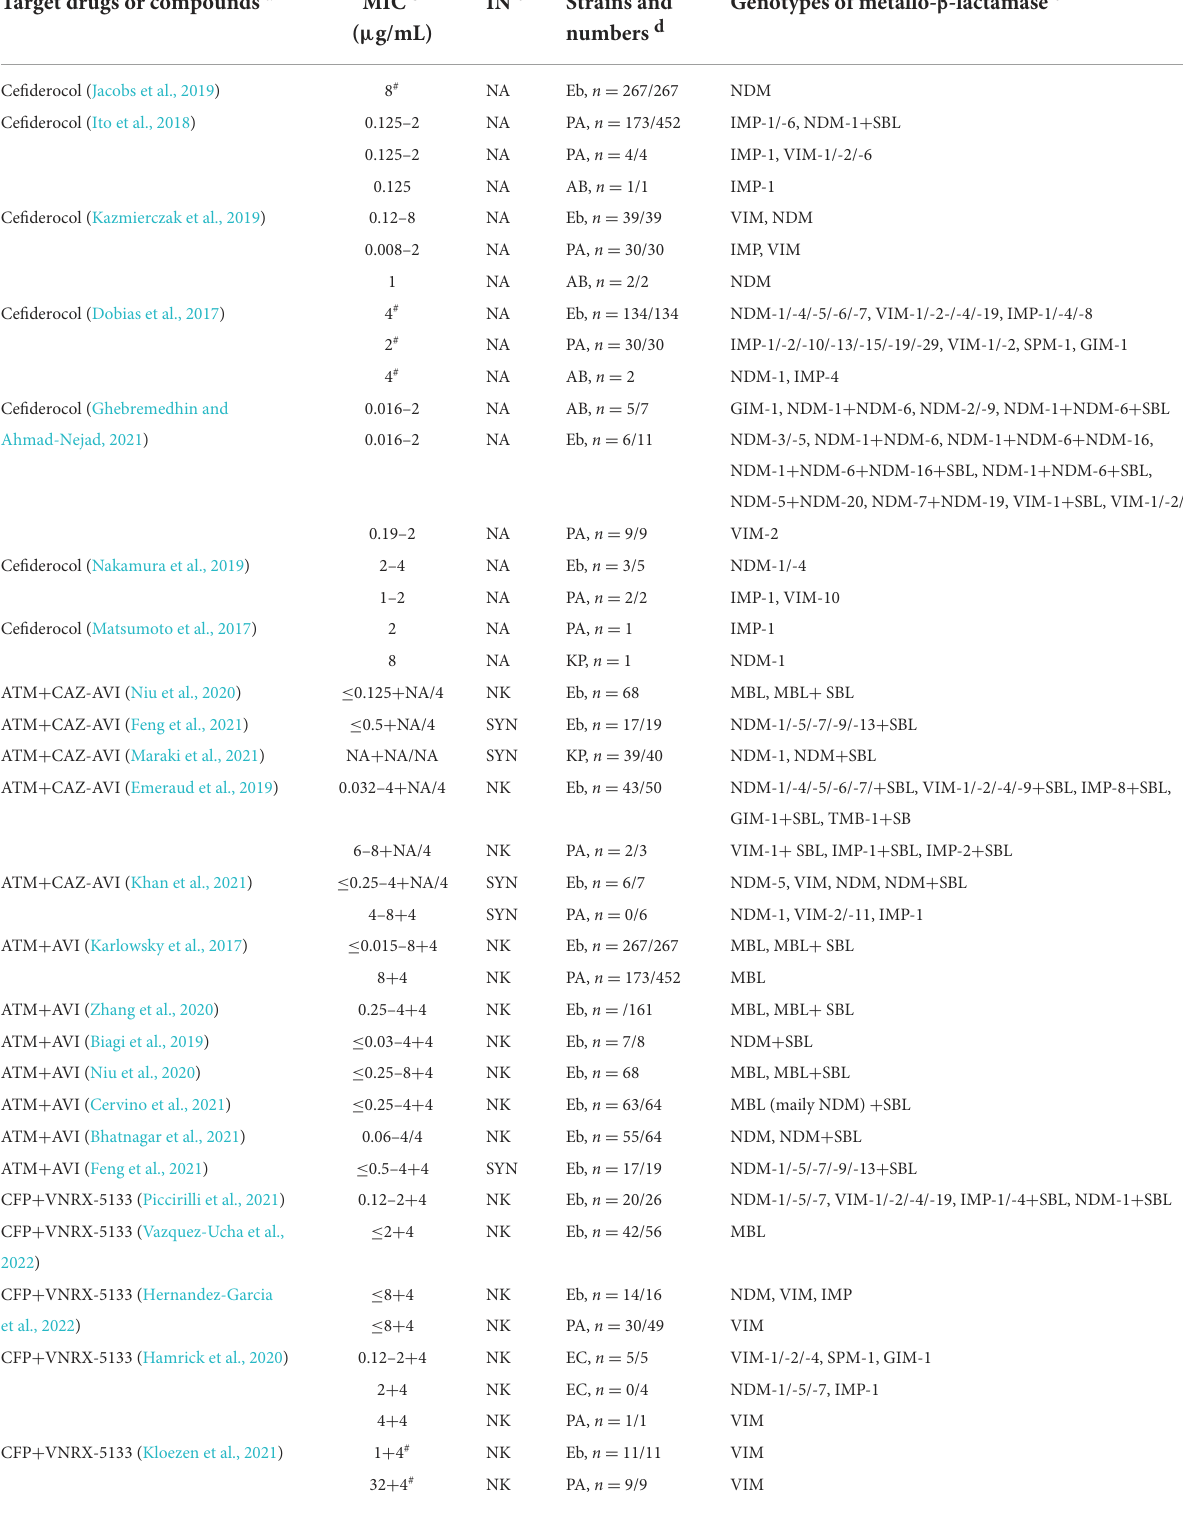
TABLE 1 In vitro activity of novel drug strategies vs. metallo- β -lactamase producers adapted from references. Target drugs or compounds